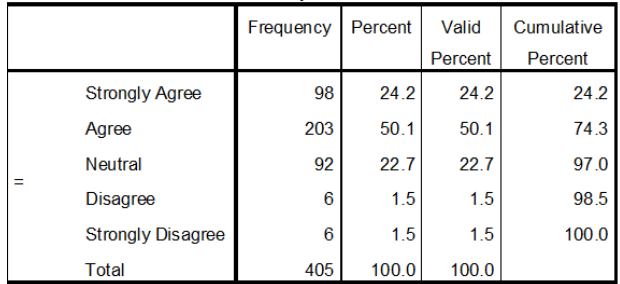
Figure 33. We ensure uninterrupted and regular availability of our cloud and IoT based platforms